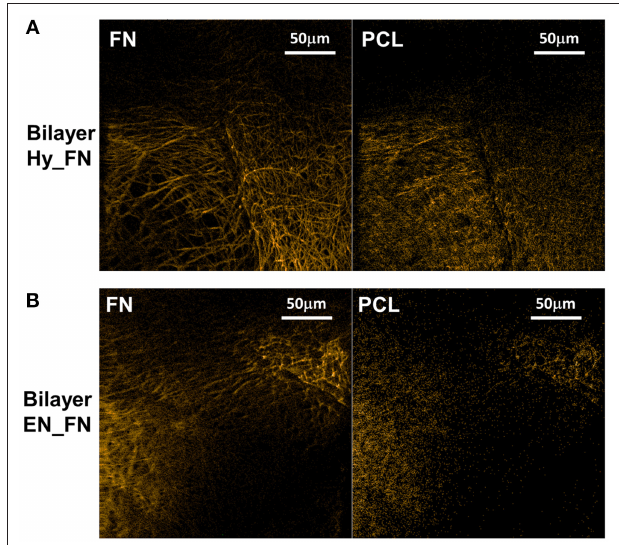
FIGURE 8 | ToF-SIMS negative polarity images of the fragments characteristic for fibronectin (left) and PCL (right) for bilayer samples Hy_FN (A) and EN_FN (B)